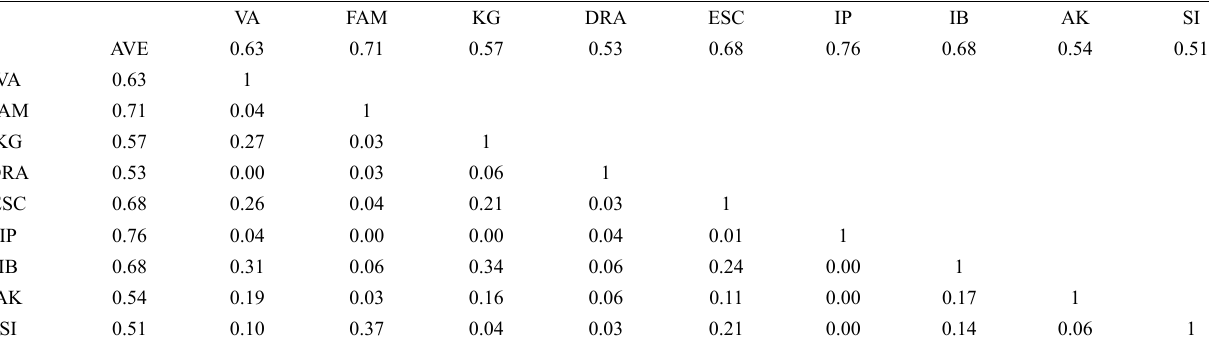
Table 4 - Discriminant validity between motives for NBA